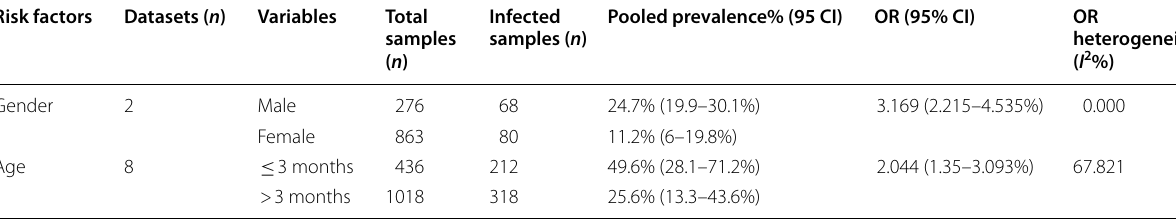
Table 3 Gender and age associated with microsporidia infection among sheep and goats worldwide Risk